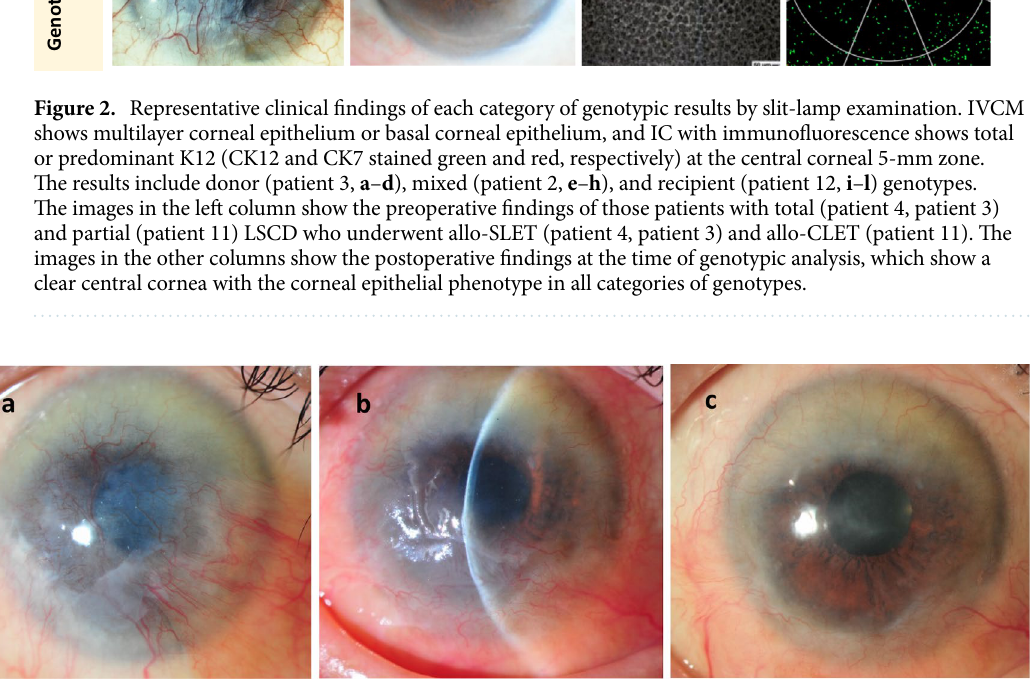
Figure 3. Representative images of a patient with a history of acute allograft rejection. Patient 6 had total idiopathic LSCD ( a ). After allo-SLET, she developed acute graft rejection at 32 months postoperatively with inflammation of the perilimbal vessels and corneal epithelial haze ( b ). The rejection recovered before the genotypic analysis at 42 months postoperatively with the recipient genotype ( c